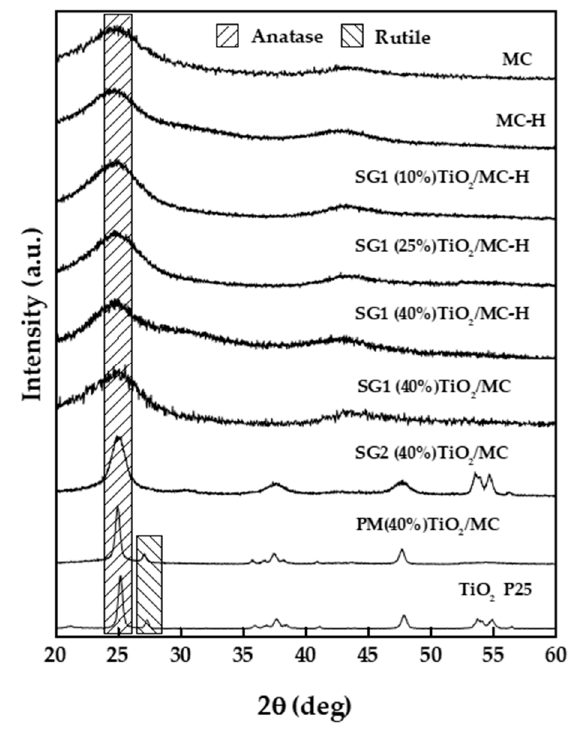
Figure 2. X-ray di ff ractograms of the di ff erent solids used in the present Figure 2. X-ray diffractograms of the different solids used in the present study.